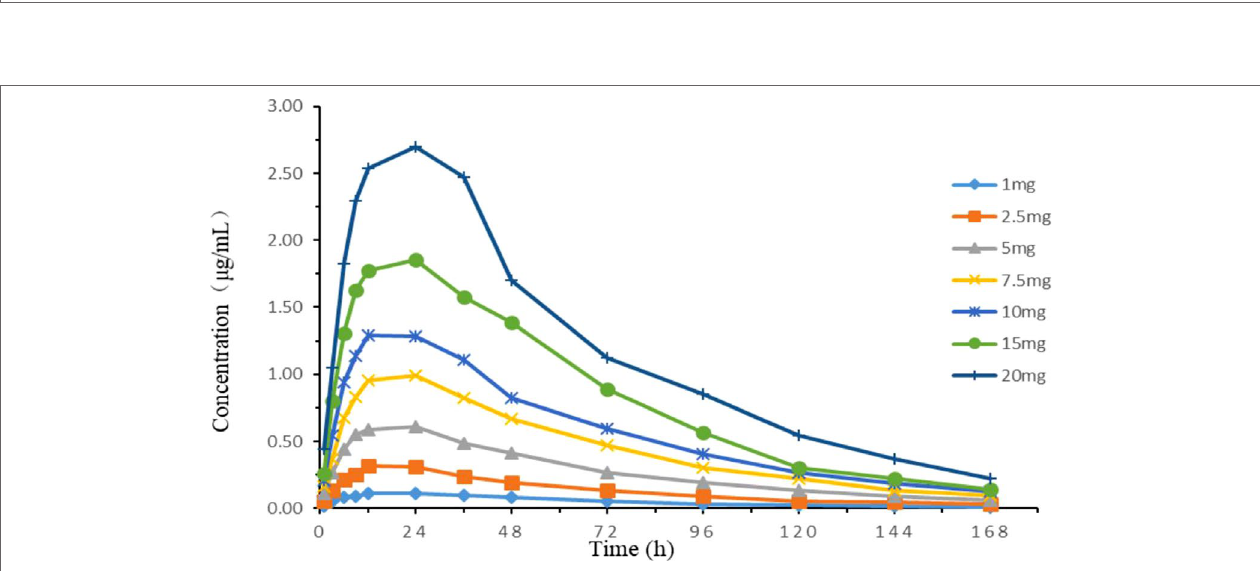
FIGURE 5 | Concentration–time curves of seven doses of tilmicosin according to the lung pharmacokinetic data of chickens in the in vitro dynamic